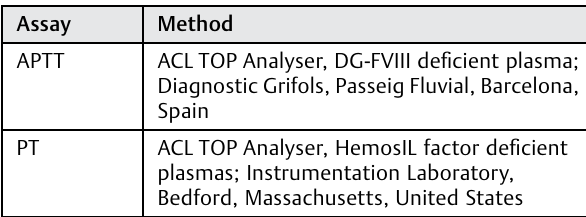
Table 1 Methods used for coagulation assays